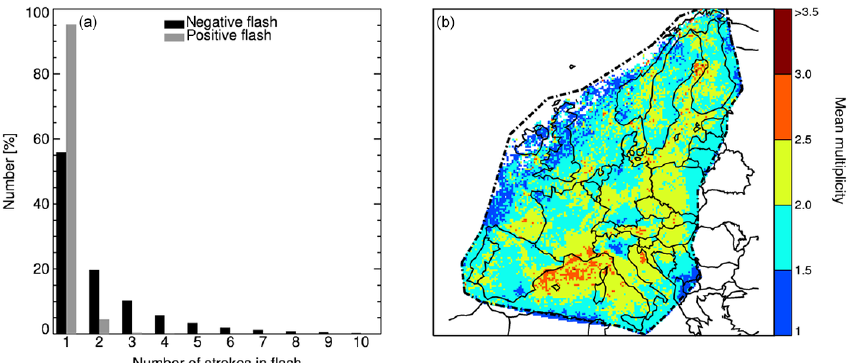
Figure 5. (a) Histogram of the percentage of strokes per flash for negative (black) and positive (grey) flashes, and (b) multiplicity distribution of negative flashes, based on 2006–2014 EUCLID data and adopting a spatial resolution of 20km × 20km.